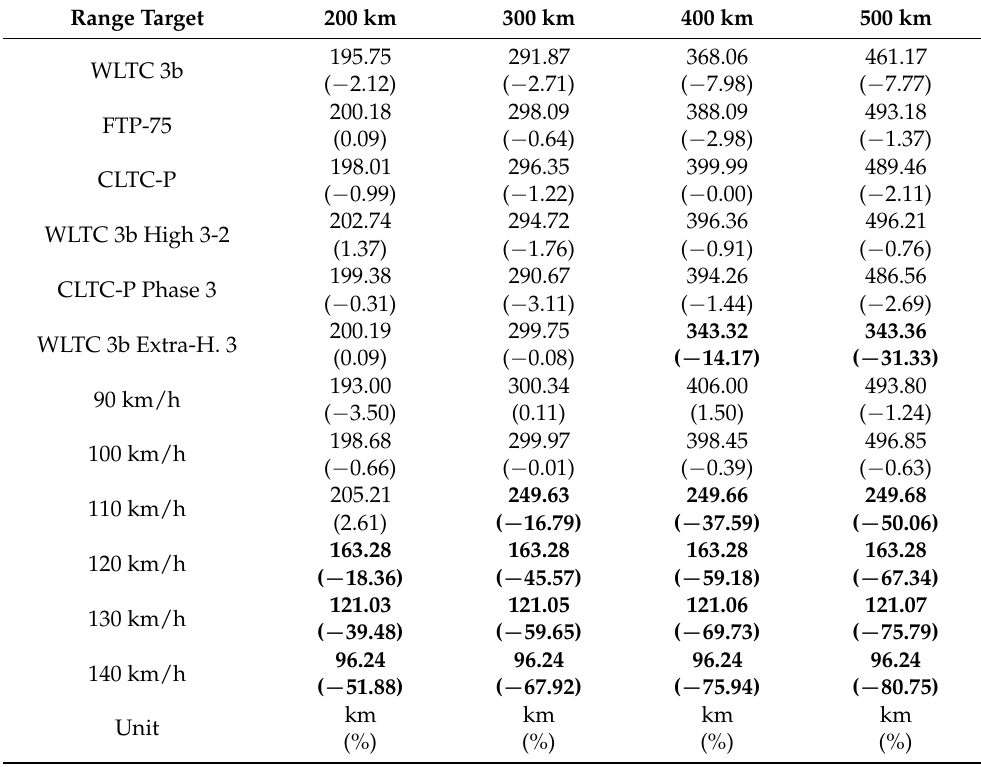
Table A2. Difference between range target and traveled range at 15% SOC. Bolded values indicate cases when the range target cannot be obtained. Vehicle mass is 2100 kg. The average percent difference (excluding data when range cannot be obtained) is − 1.34%, with a standard deviation of 2.18%.